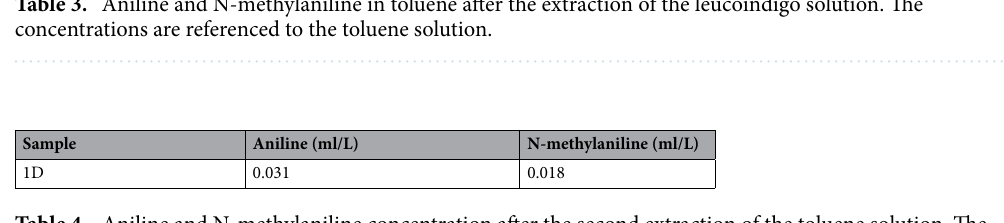
Table 4. Aniline and N-methylaniline concentration after the second extraction of the toluene solution. The concentration is referenced to the toluene solution.